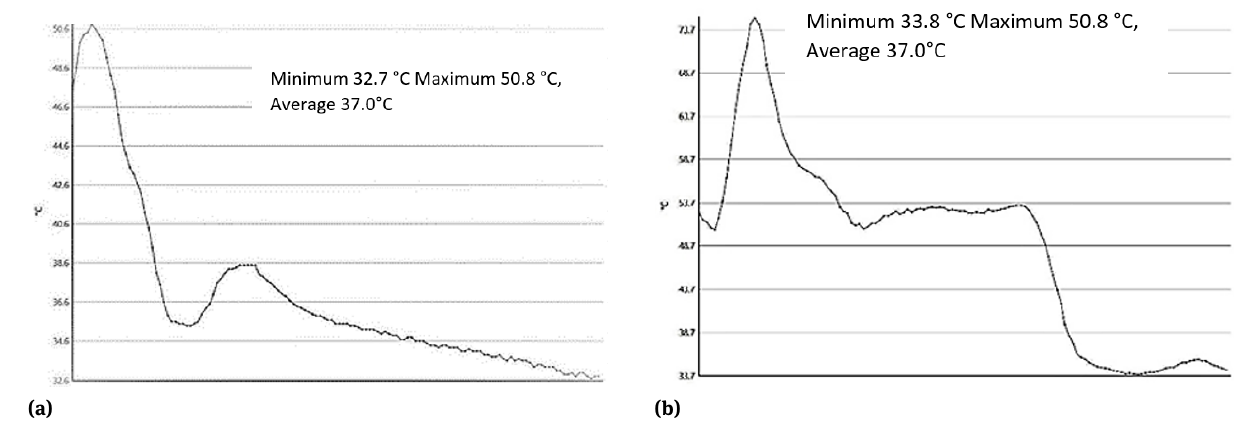
Figure 6: Temperature profile at the electrode when a) stainless Al electrode used with stainless steel tank b) Two electrodes of steel and Al alloy electrode are